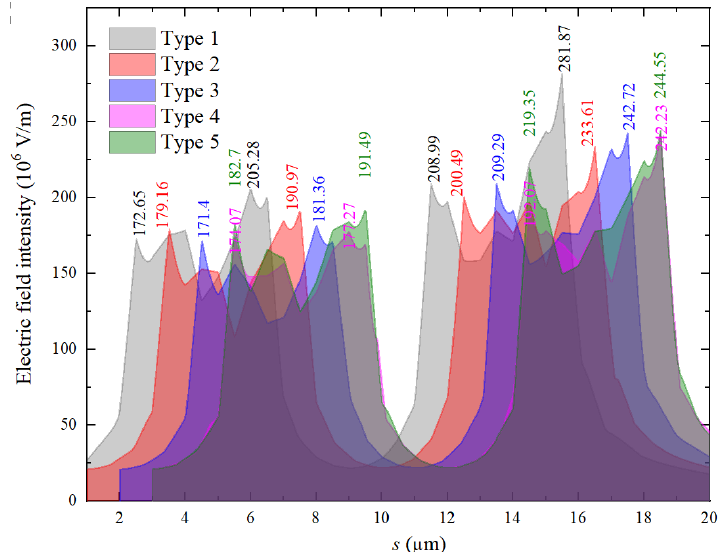
Figure 4. Distribution of the electric field around the fingers on the electrodes.